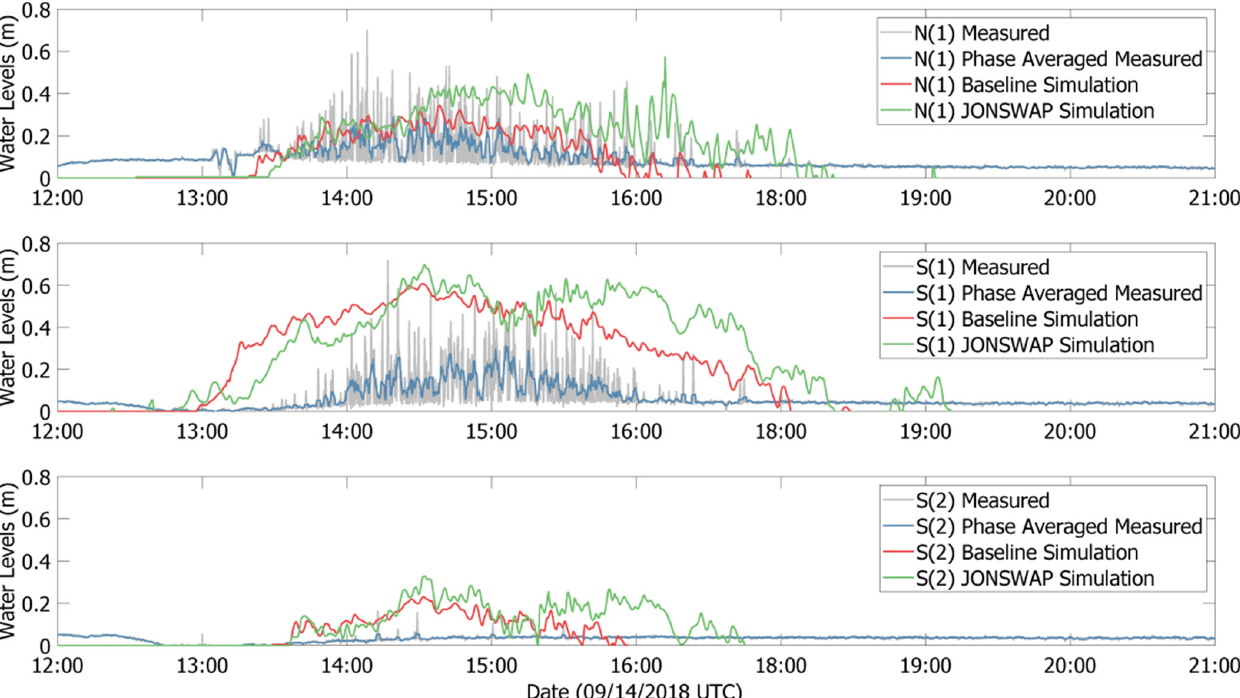
Figure 4. Comparisons between measured and modeled beachface water levels from simulations using measured directional wave spectra (baseline simulation) and parameterized wave spectra (JONSWAP simulation). A 2 min moving average was also completed on the modeled beachface water levels.